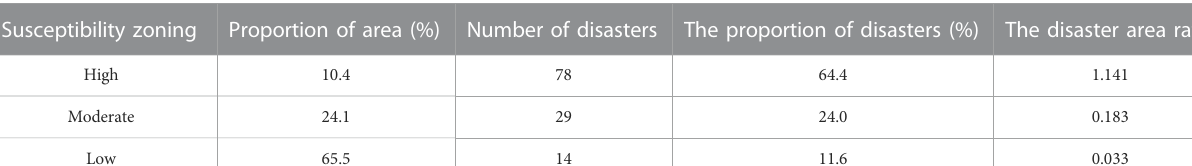
TABLE 5 The disaster area ratio of EWM-Apriori-IV model evaluation results.